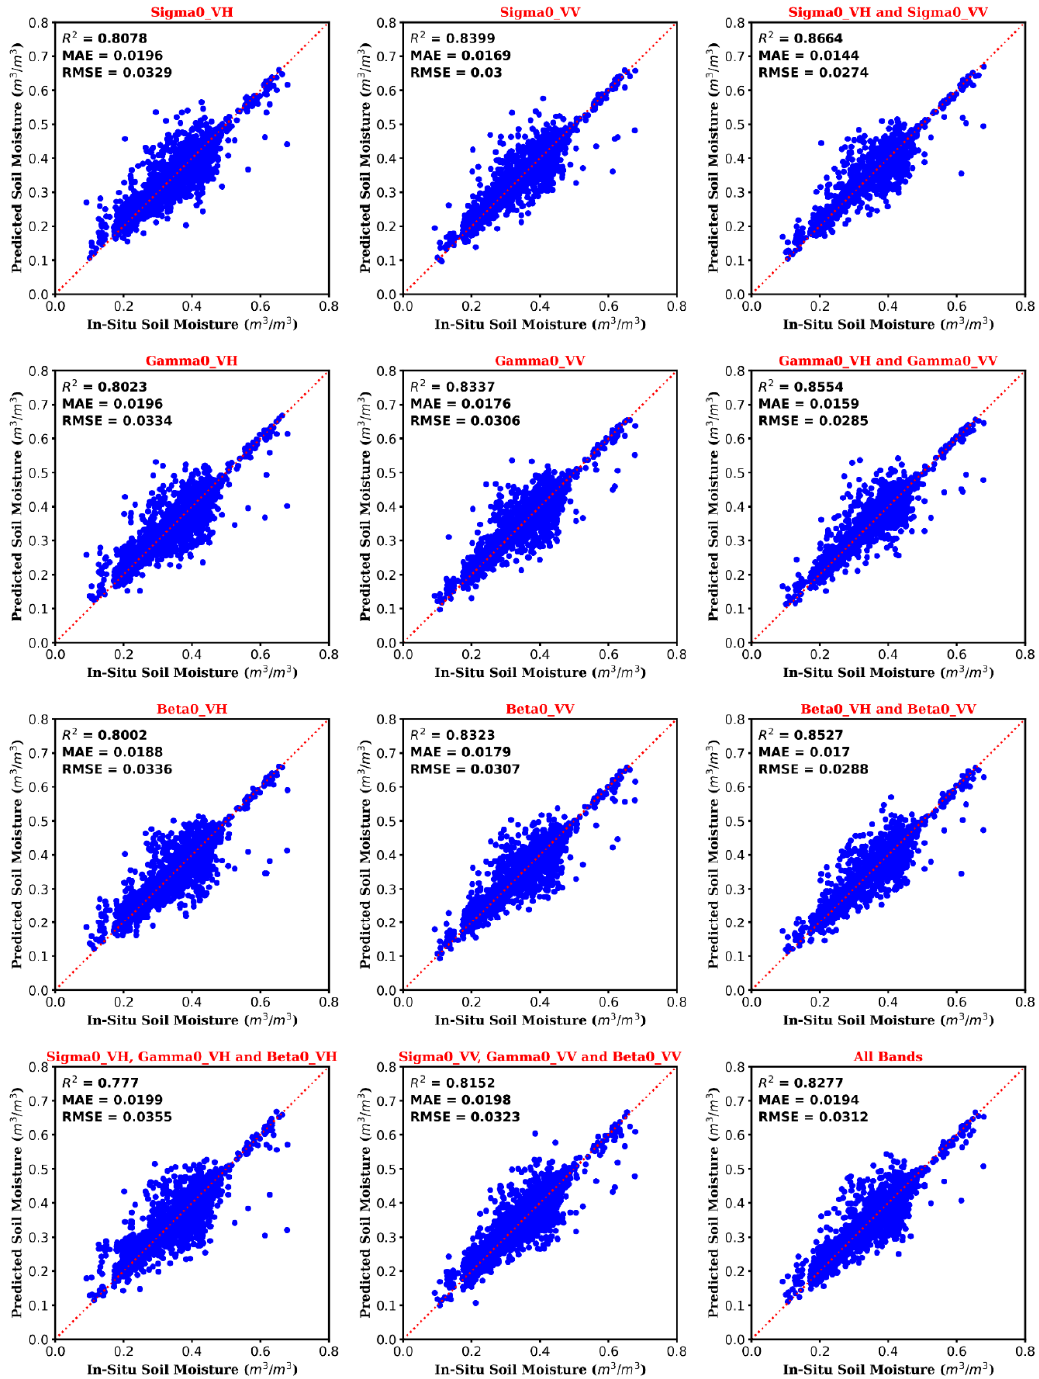
Figure 2. An illustration of the effect of Sentinel-1 bands on the soil moisture retrieval accuracy over agricultural areas.